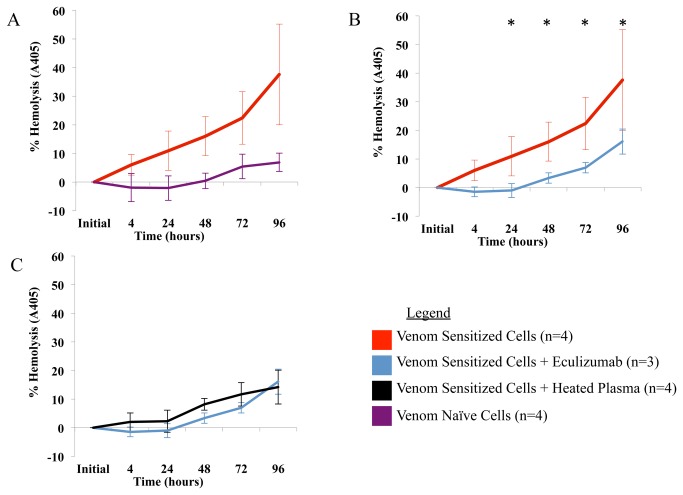
Effect of eculizumab on

L

. reclusa
 associated hemolysis in vitro.(A)

L

. reclusa
 venom sensitized cells are hemolyzed over time when incubated with ABO identical plasma, compared to venom naïve RBCs. (B) This hemolysis is reduced by an average of 79.2% (SD = 18.8%) when eculizumab is added to the assay. (C) Eculizumab was statistically indistinguishable from heat inactivation at all timepoints. Results are averages of 3-4 experiments. Error bar shows results +/- 1 standard deviation. Asterisk indicates statistical significance, p<.001.